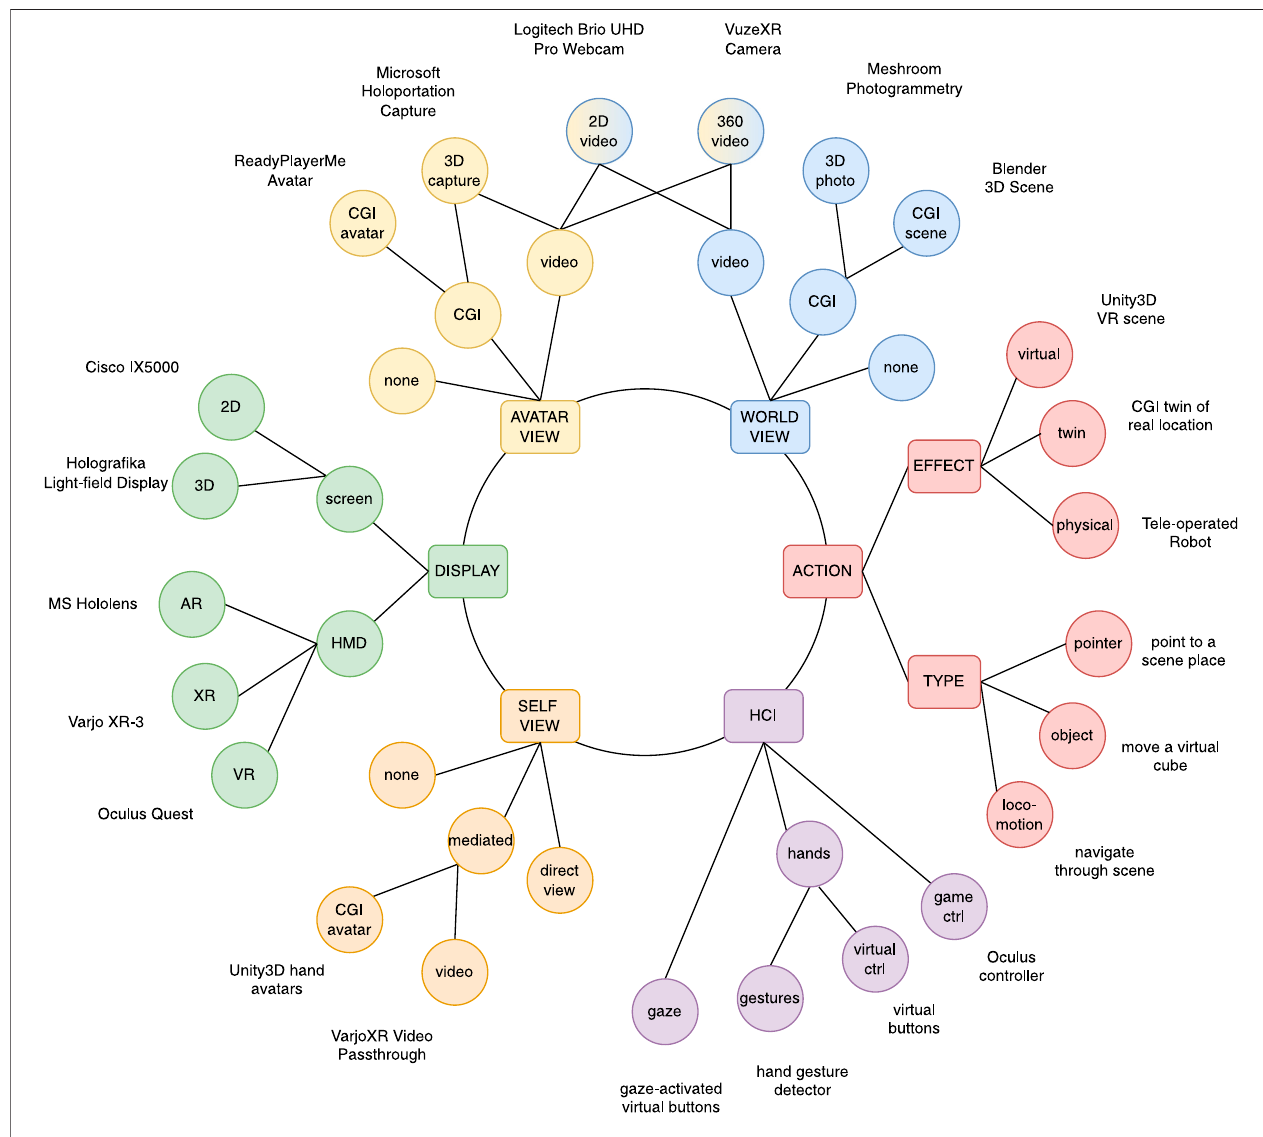
FIGURE3| Componentsofanimmersivecommunicationsystem.Itincludesthemaincategories,atwo-levelclassi fi cationoftechnologieswithinthosecategories, and one example for each of them, mostly from commercial products. Categories intend to be exhaustive; examples do not.